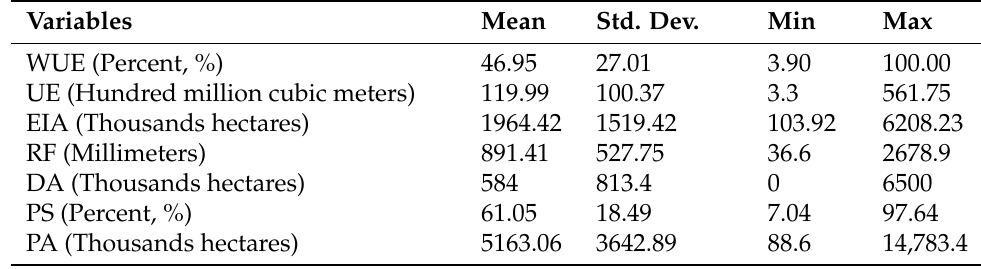
Table 2. Descriptive statistics of the selected